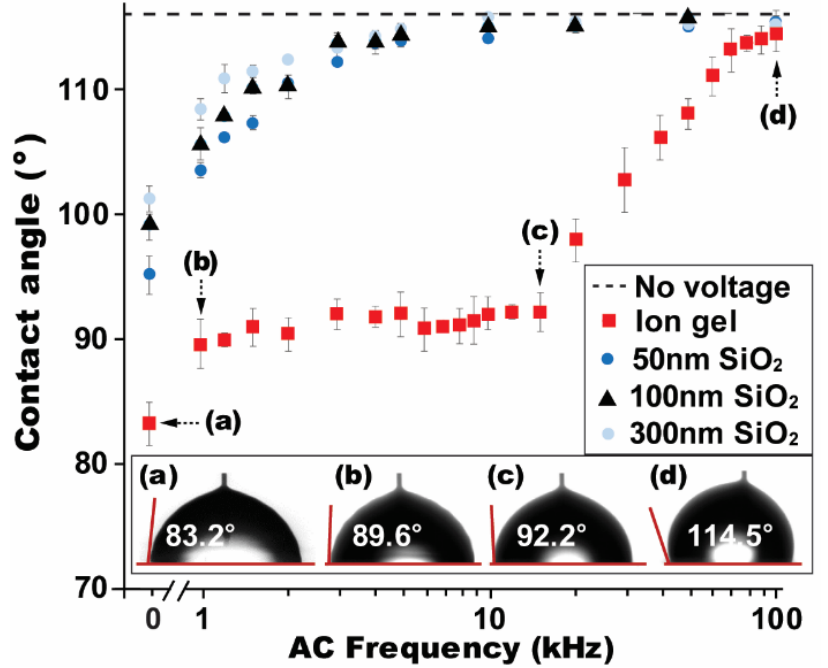
Figure 2. High-frequency AC electrowetting performance. Droplet’s contact angle was measured on various dielectric layers such as 8.3 µ m ion gel and 50, 100 and 300 nm SiO 2 covered with a 150 nm Teflon layer, while an applied AC frequency was varied from 1 to 100 kHz. Due to the high-capacitance dominance of the ion gel up to 15 kHz, the contact angle modulation is far superior, compared to SiO 2 . The AC electrowetting performance was further compared with DC cases where much lower contact angles are observed. All experiments were conducted at a fixed voltage of V RMS = 42.4 V.